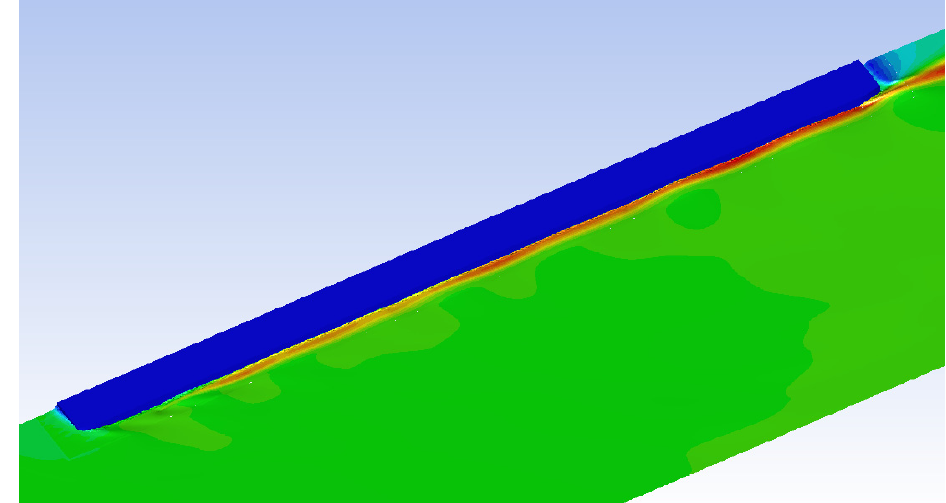
Figure 4. Velocity magnitude on the free water surface (Layout E, deep water). Source: Authors.